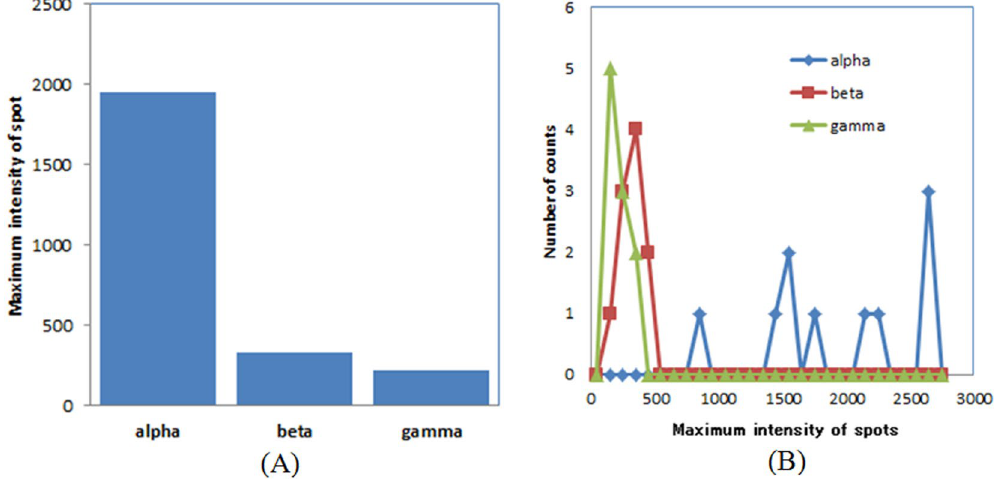
Figure 10. Average maximum intensity ( A ) and maximum intensity distribution ( B ) for alpha particles, beta particles, and gamma